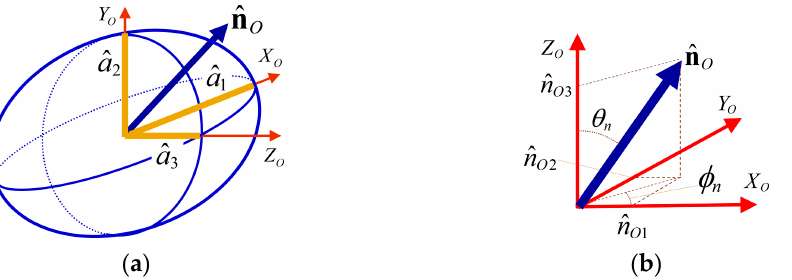
Figure 1. ( a ) Leaving aside the intensity, the polarization state is fully characterized by its polarization density object, composed of the polarization density ellipsoid E (with semiaxes ˆ a 1 ≥ ˆ a 2 ≥ ˆ a 3 ), together with the spin density vector ˆ n O . ( b ) ˆ n O is determined by its magnitude | ˆ n O | ≡ P c and its orientation angles φ n , θ n with respect to the symmetry axes X O Y O Z O of E . The polarization object can be expressed in terms of the intrinsic Stokes parameters and therefore it has tensor character in the sense that it is invariant with respect to changes of the reference frame. When the polarization density object is referenced with respect to an arbitrary coordinate system, the orientation angles ( , , ) φθϕ of the polarization density ellipsoid should be considered as additional parameters.